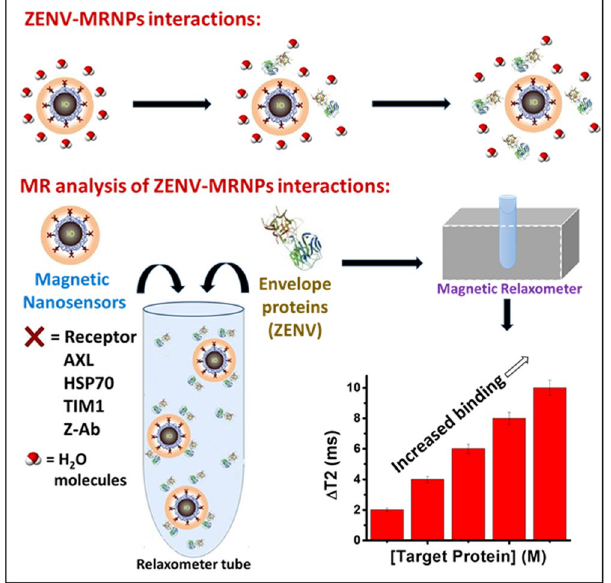
Figure 1. ZENV-MRNPs interactions: Schematic representation of neighboring water proton displacement by ZENV-MRNPs interactions in solution. MR analysis of ZENV-MRNPs interactions: Magnetic relaxation (MR) nanosensor for the assessment of these interactions and receptor